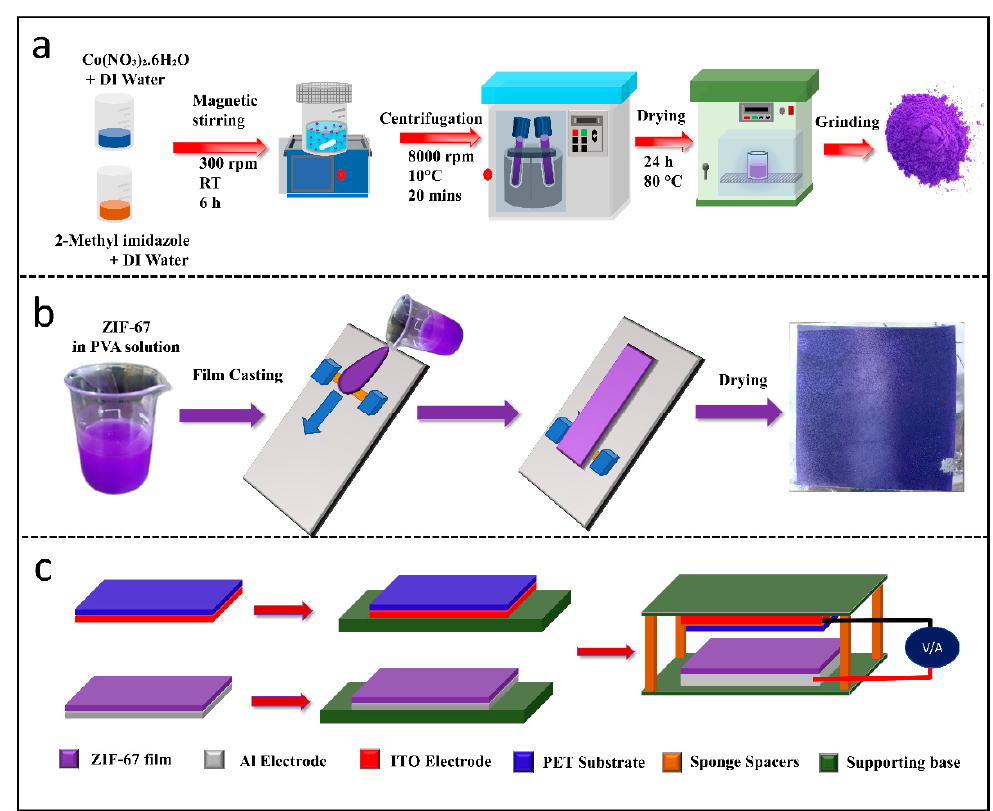
Figure 1. ( a ) Synthesis steps of ZIF-67 powder, ( b ) ZIF-67 film preparation steps using doctor blade method, ( c ) TENG device fabrication steps.